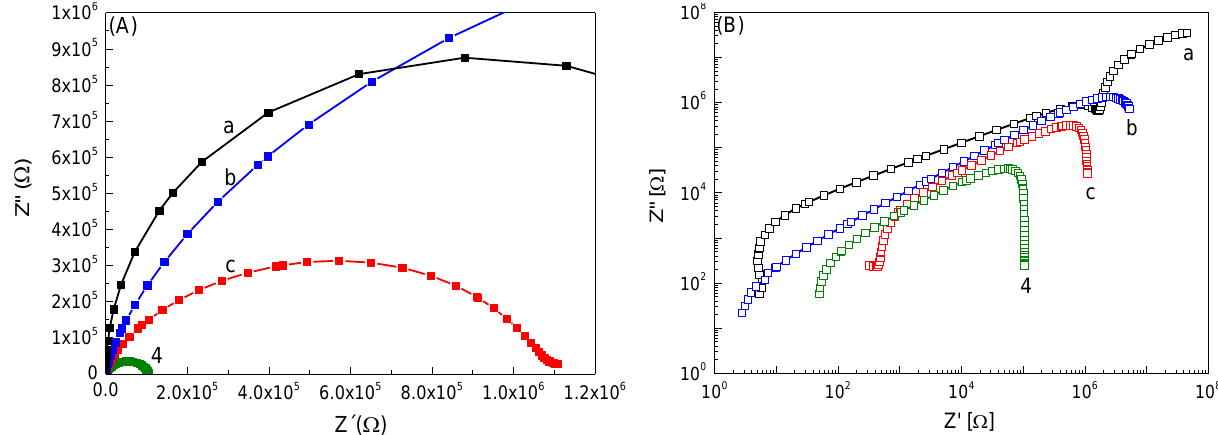
Figure 7. Comparison of the RhB removal between the original (1st run), reused without thermal regeneration (2nd run), and thermally regenerated catalysts (2nd run activated). Time = 360 min. The electrical behavior of the samples was studied over a wide range of temperatures and frequencies using impedance spectroscopy (IS). The typical complex impedance plots of all BaTiO 3 modified with MnO 2 ceramics at 473 K are shown in Figure 8. The impedance data are presented as Nyquist plots in linear (Figure 8A) and log – log (Figure 8B) systems. The impedance spectrum is only a segment of an arc due to the limit of measuring frequency. Usually, a conduction process results in a semi-circular arc in a linear complex plane plot. The log – log presentation in Figure 8B enables us to compare the measured impedance of all the samples in one plot. Moreover, the logarithmic plot still offers significant advantages in several respects, which were discussed by Jonscher [35]. The plot for the BaTiO 3 ceramic in Figure 8B confirms the existence of two semi-circle arcs that are not visible in Figure 8A. In the impedance spectra, we attribute the higher frequency response (small arc) to the grains, and the lower one to the grain boundaries [36]. Other samples with additions of MnO 2 show one semi-circle arc. The dimensions of the semi-circular arcs correspond to the resistance values of the measured ceramics. In Figure 8B, we can see a decrease in the impedance with an increase in wt.% of MnO 2 . Furthermore, all semi-circular arcs shift from right to left and have reduced diameters as temperature increases due to the associated decreases in impedances (not shown here). The observed decrease in the radius value of the semi-circle with increasing manganese content may be related to a faster rate of separation and transfer of electron – hole pairs, wherein a larger radius indicates a larger charge transfer resistance; thus, a lower separation efficiency of photogenerated electron – hole pairs.